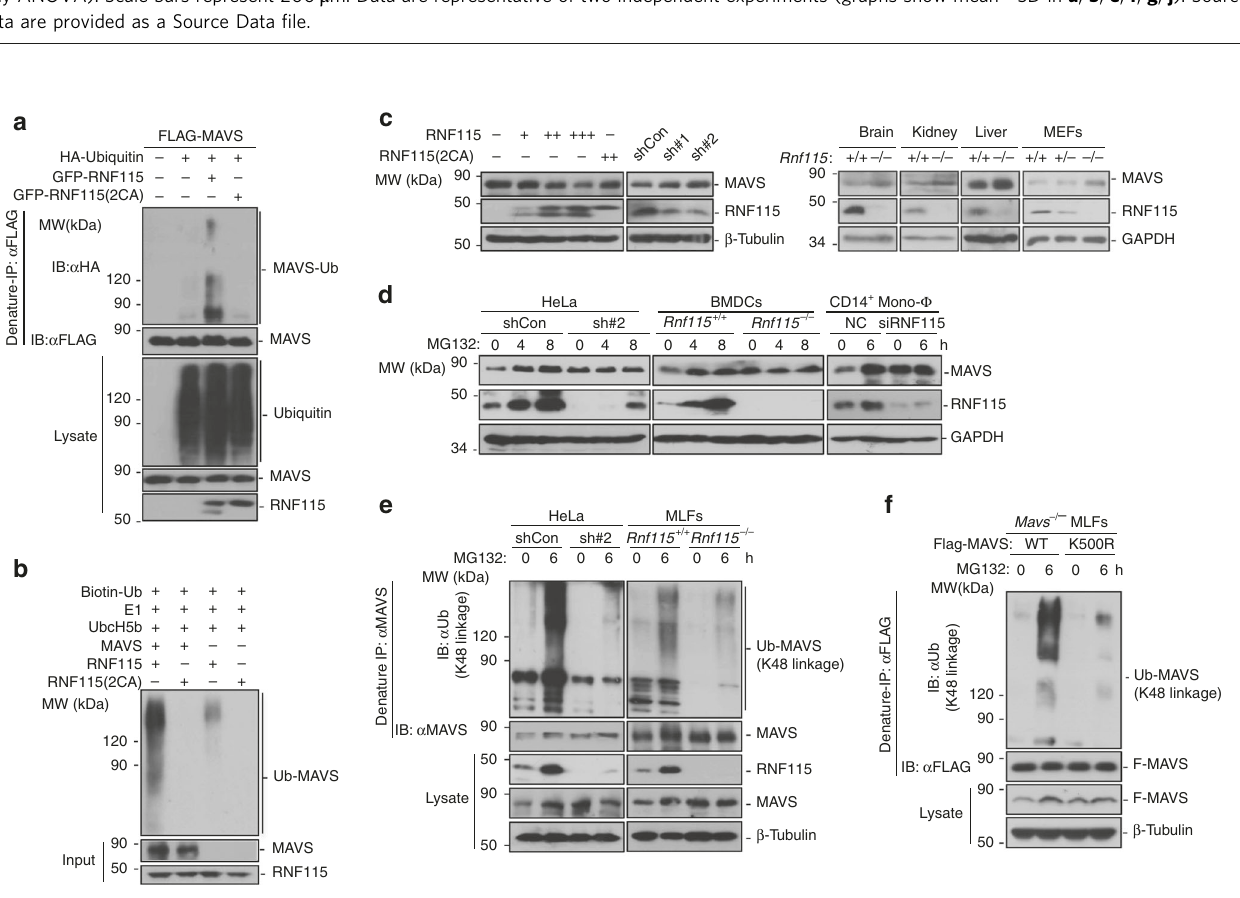
Fig. 6 RNF115 mediates K48-linked ubiquitination and proteasomal degradation of homeostatic MAVS. a Denature-immunoprecipitation (Denature-IP) (with anti-FLAG) and immunoblot analysis (with anti-FLAG, anti-HA, or anti-GFP) of HEK293 cells transfected with plasmids encoding FLAG-MAVS, HA- Ubiquitin, and empty vector, GFP-RNF115, or GFP-RNF115(2CA) for 24 h. b In vitro ubiquitination analysis of ubiquitin-modi fi ed MAVS. MAVS, RNF115, and RNF115(2CA) were translated in vitro, Biotin-Ub, E1, and UbcH5 were added for ubiquitination assays. Ubiquitin-conjugated MAVS was detected by immunoblot with HRP – streptavidin (upper panel). The proteins in the input were detected by immunoblot with the indicated antibodies (lower panels). c Immunoblot of HeLa cells that were transfected with plasmids encoding RNF115 (0, 200, 400, 600 ng, respectively) and RNF115(2CA) (400 ng) for 24 h (upper left panels), or transfected with shRNA(Con, shRNF115#1 or shRNF115#2) for 36 h (upper right panels), lysed and analyzed by immunoblot with anti-MAVS, RNF115, and β -Tubulin. Immunoblot analysis of RNF115, MAVS, and GAPDH in brains, kidneys, livers from Rnf115 + / + and Rnf115 − / − mice, or in Rnf115 + / + , Rnf115 + / − , and Rnf115 − / − MEFs (lower panels). d Immunoblot analysis of MAVS, RNF115, and GAPDH in HeLa cells that were transfected with shCon or shRNF115#2 for 36 h, in Rnf115 + / + and Rnf115 − / − MLFs treated with MG132 for 0 – 8 h or in human CD14 + monocytes-derived macrophages transfected with control siRNA (NC) or siRNF115 followed by treatment of MG132 for 0 – 6 h. e Denature-IP (with anti-MAVS) and immunoblot analysis (with anti-K48 linkage polyubiquitin, anti-MAVS, anti-RNF115, or anti-GAPDH) in HeLa cells that were transfected with shCon and shRNF115#2 for 36 h or in Rnf115 + / + and Rnf115 − / − MLFs treated by MG132 for 0 – 6 h. f Denature-IP (with anti-FLAG) and immunoblot analysis (with anti-K48 linkage polyubiquitin, anti-FLAG, or anti-GAPDH) of Mavs − / − MLFs reconstituted with MAVS or MAVS(K500R) treated with MG132 for 0 – 6 h. Data are representative of three ( a , b ) or two ( c – f ) independent experiments. Source data are provided as a Source Data fi